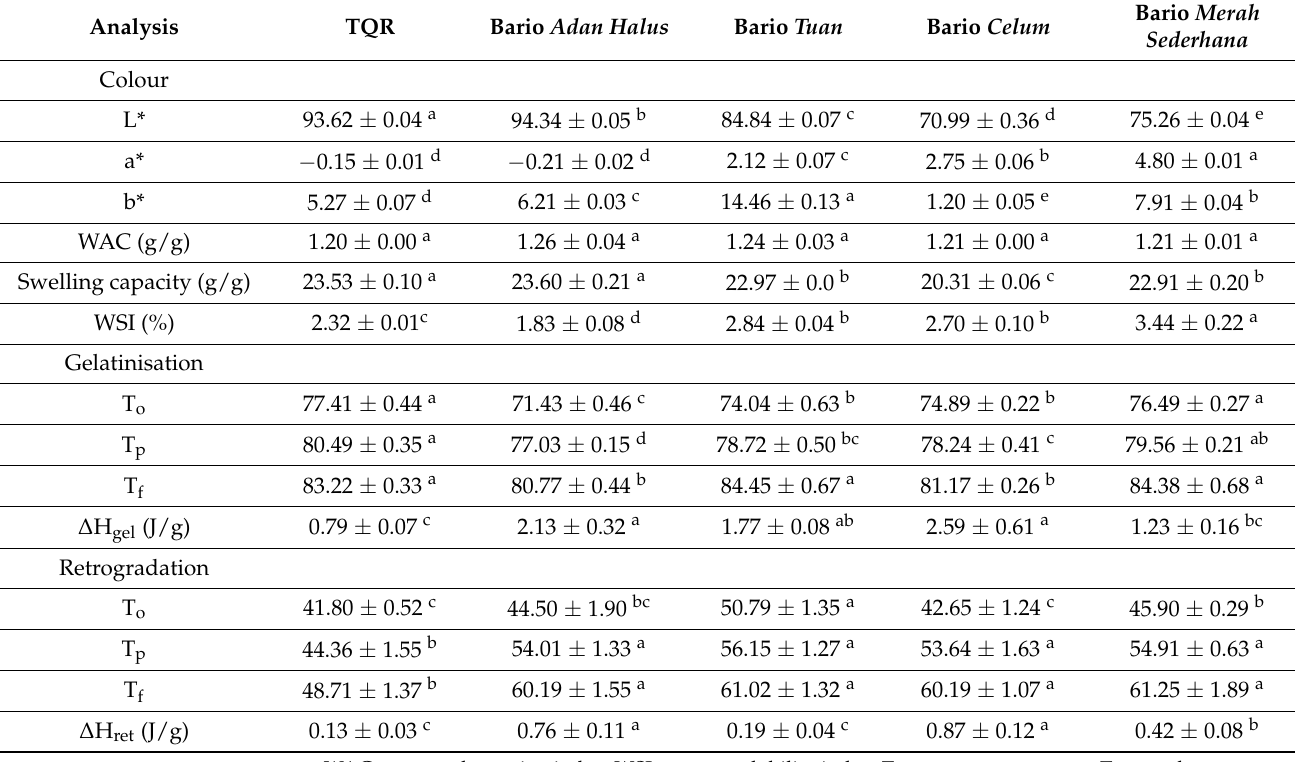
Table 2. Physicochemical properties of Bario rice varieties compared with TQR